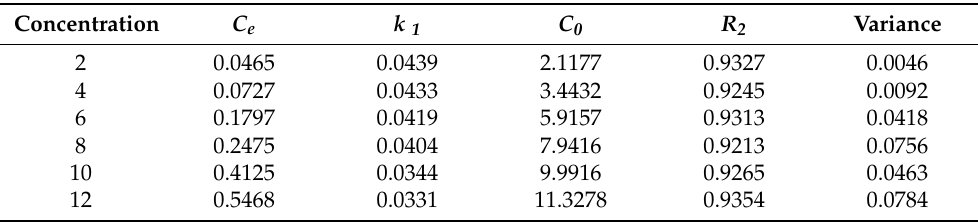
Table 9. Estimated parameter values of the PFO models by the numerical calculations for the extraction process at different dye concentrations.